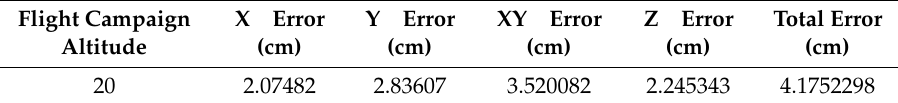
Table 2. Root mean square error of the ground control